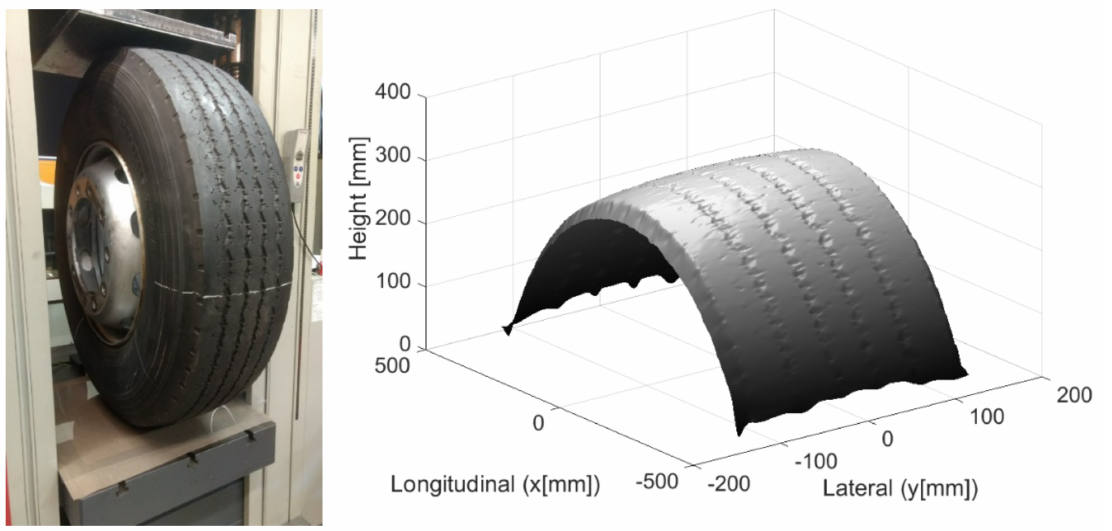
Figure 4. Experimental set-up and numerical reconstruction of the surface